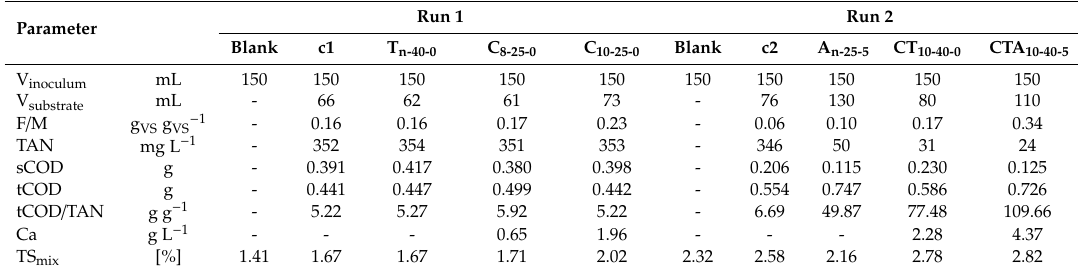
Table 2. Main characteristics of the biochemical methane potential (BMP) tests on pretreated SW. Run 1 Run 2 Parameter Blank c1 T n-40-0 C 8-25-0 V inoculum mL